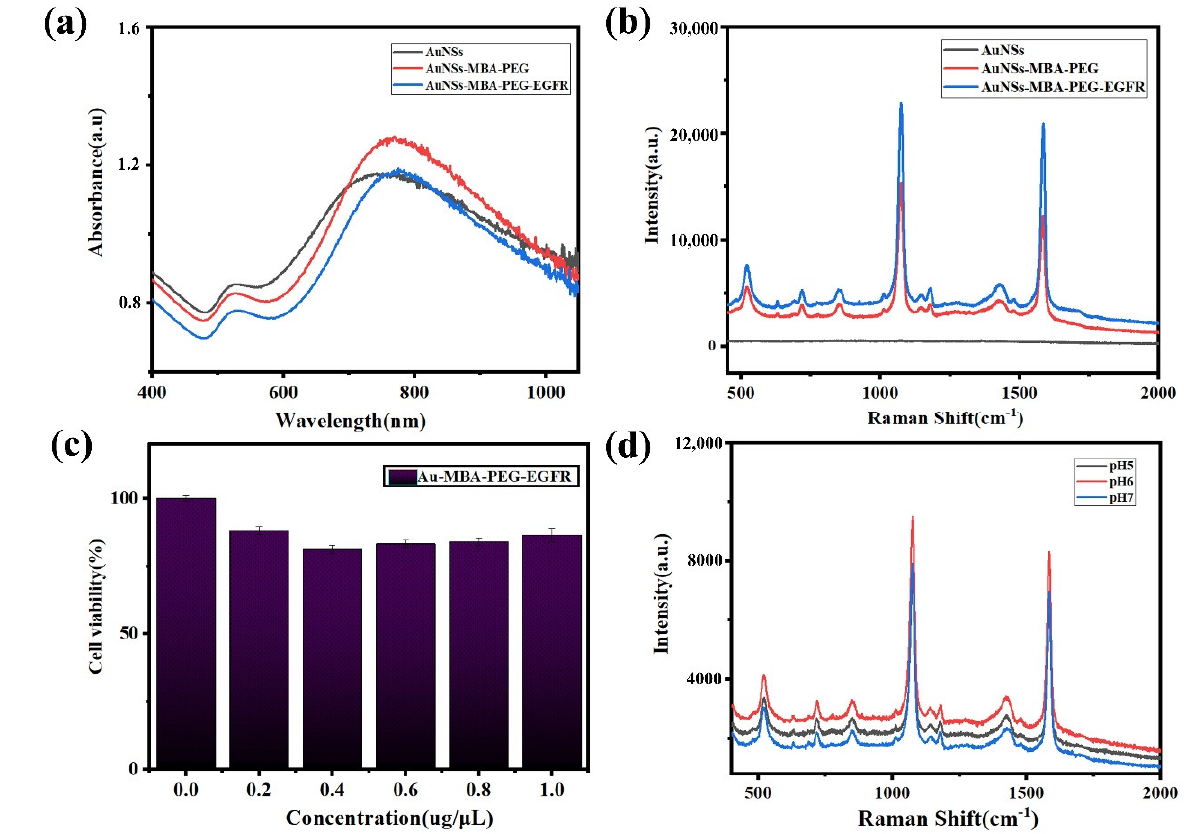
Figure 3. Synthesis and characterization of functional nanomaterials. ( a ) UV−visible absorption spectra of AuNSs, 4−MBA−labeled AuNSs, PEG−4−MBA−labeled AuNSs, and EGFR−PEG−4−MBA−labeled AuNSs. ( b ) Raman spectra of AuNSs, PEG−4−MBA−labeled AuNSs, and EGFR−PEG−4−MBA−labeled AuNSs. ( c ) Cytotoxicity test of EGFR−PEG−4−MBA−labeled AuNSs. ( d ) pH value optimization.